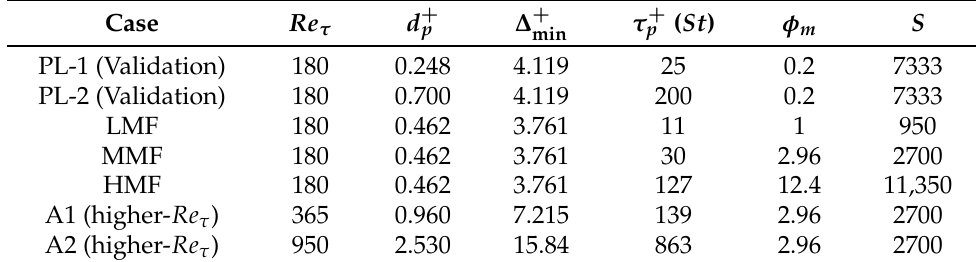
Table 9. Comparison between minimum ∆ + , τ + p , φ m , and d + p for each